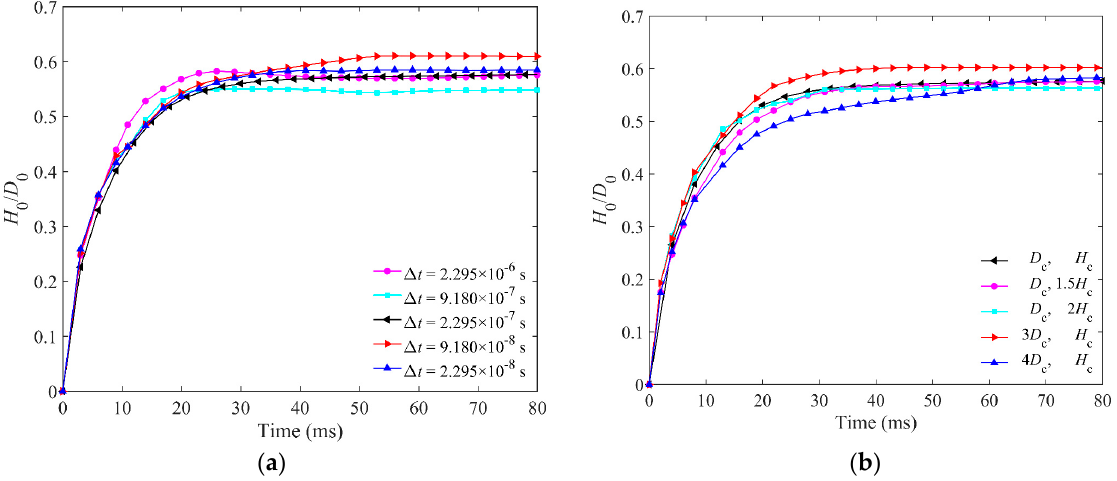
Figure 3. ( a ) Comparison of the penetration depth of glass impactor for five different time steps in DEM simulations. ( b ) Comparison of the penetration depth of glass impactor for five different cups in DEM simulations. (The length of elongated particles is 10 mm, the velocity of glass impactor is 3.60 m/s, and D c and H c are shown in Table 2).